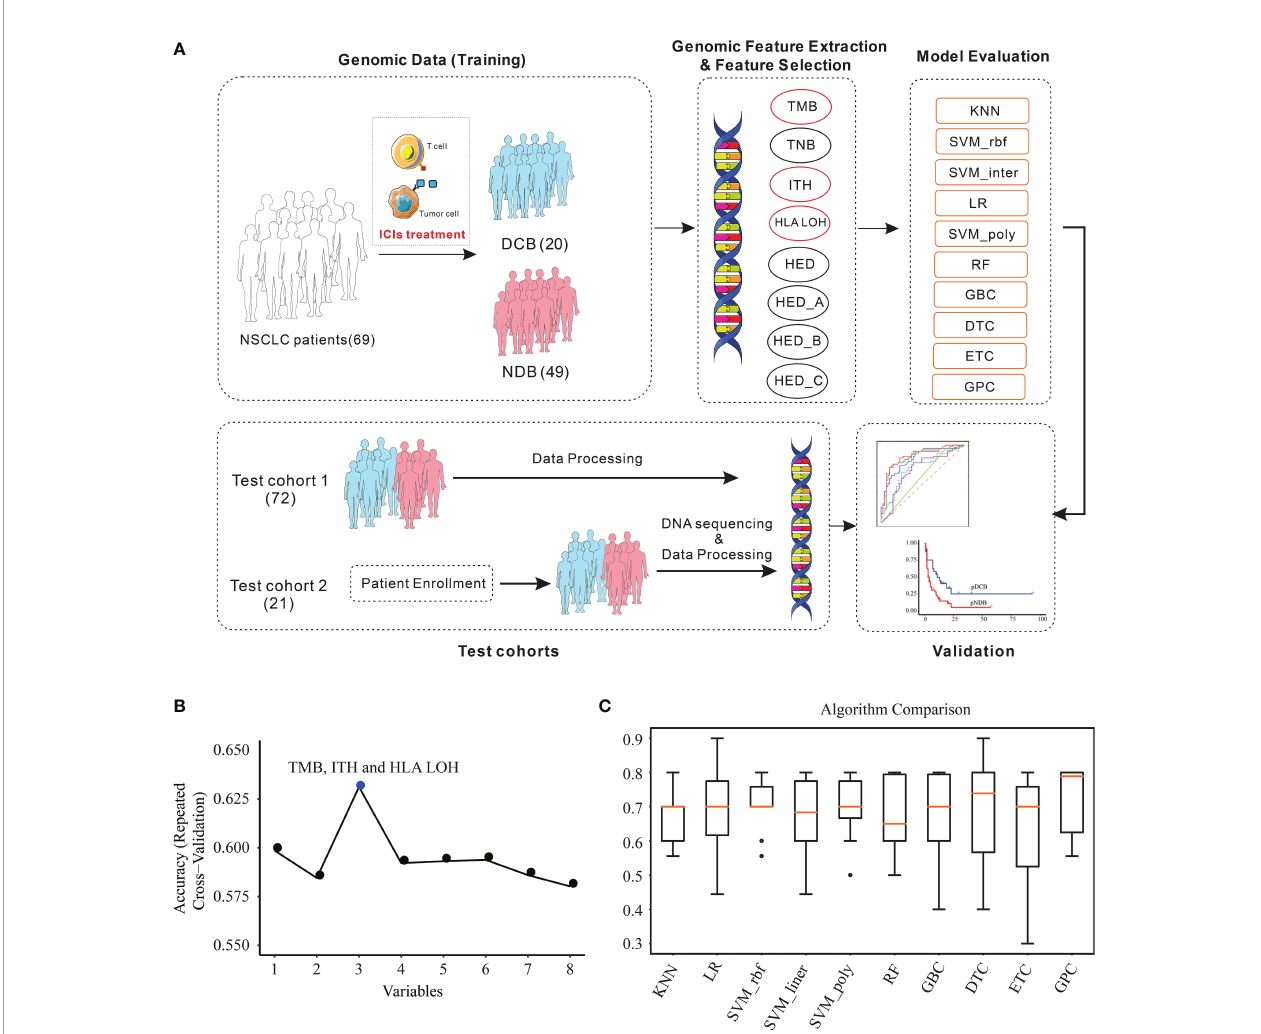
FIGURE 2 | Feature combination selection and performance evaluation. (A) Work fl ow of the study. (B) Feature combination selection with 10-fold cross-validation. (C) Comparison of the ef fi cacy of different algorithms in the training cohort with the selected features. KNN, K-nearest neighbors; LR, logistic regression; RF, random forest; GBC, gradient boosting classi fi er; DTC, decision tree classi fi er; ETC, extra tree classi fi er; GPC, Gaussian process classi fi er; SVM, support vector